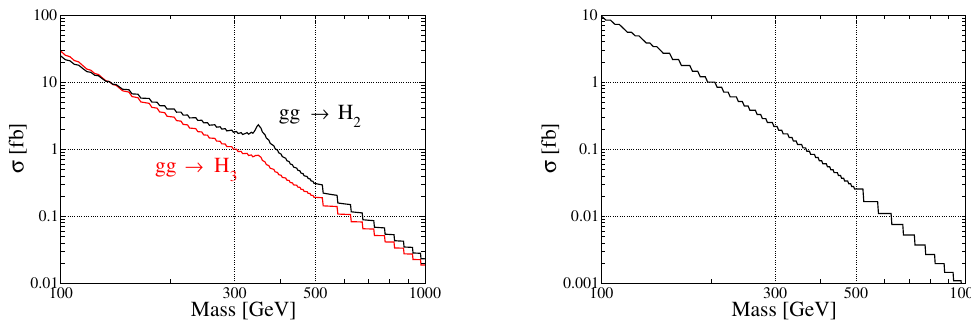
p s = 13 TeV ( (cid:30) 0 = H 2